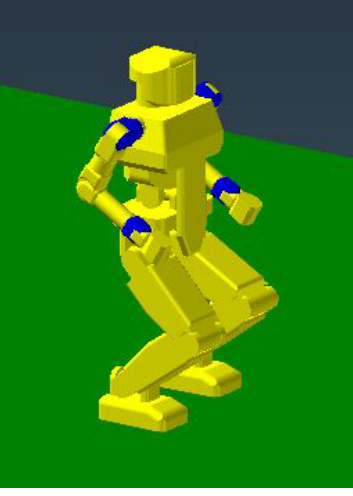
Figure 6. HYBRO. Table 1. Robot